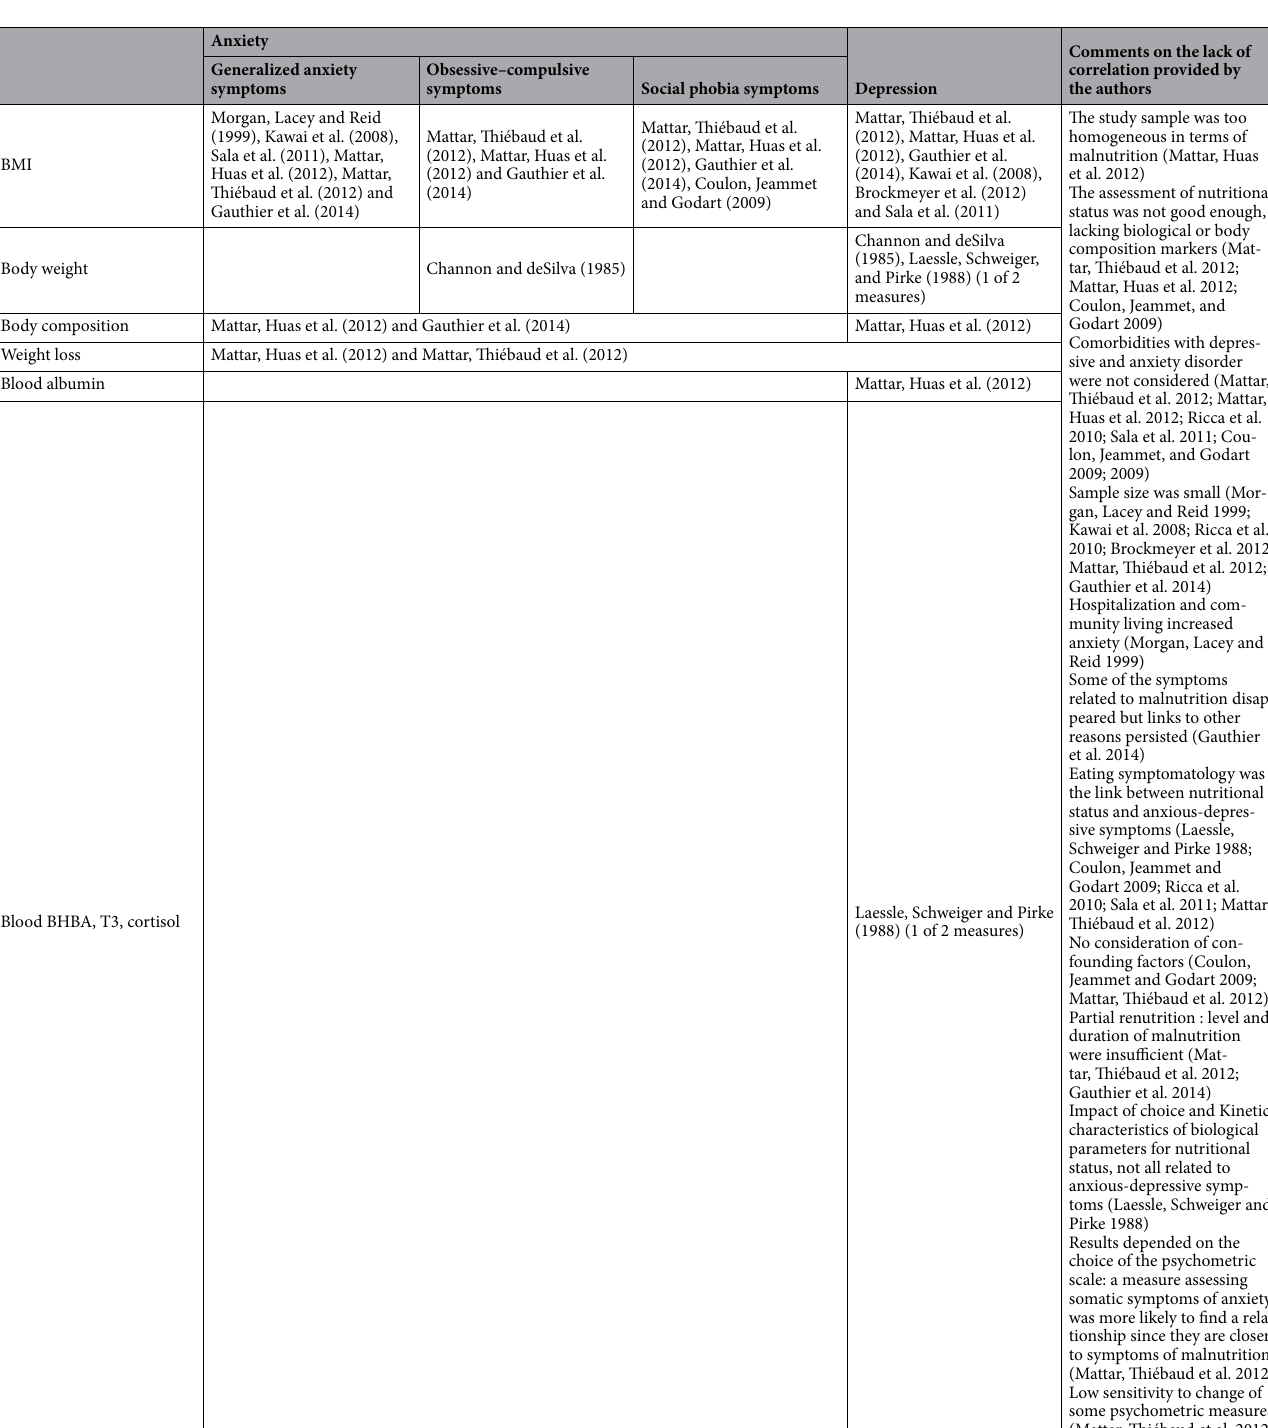
Table 1. Studies demonstrating a lack of correlation between anxious-depressive symptoms and nutritional status among patients with anorexia nervosa. BHBA beta-hydroxybutyric